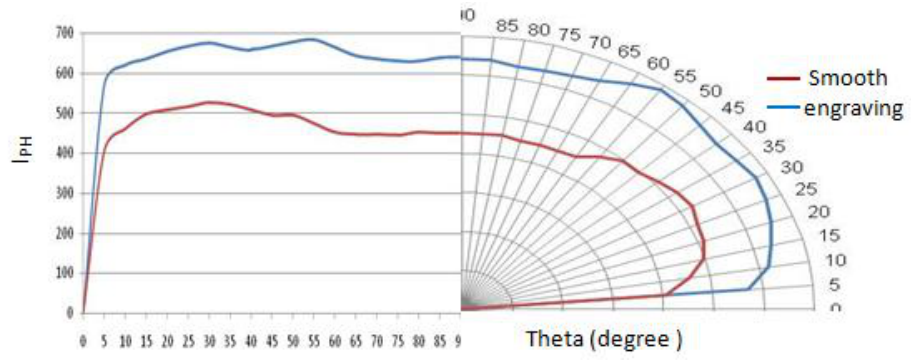
Fig.6: Photo current as a fundamental of incident light